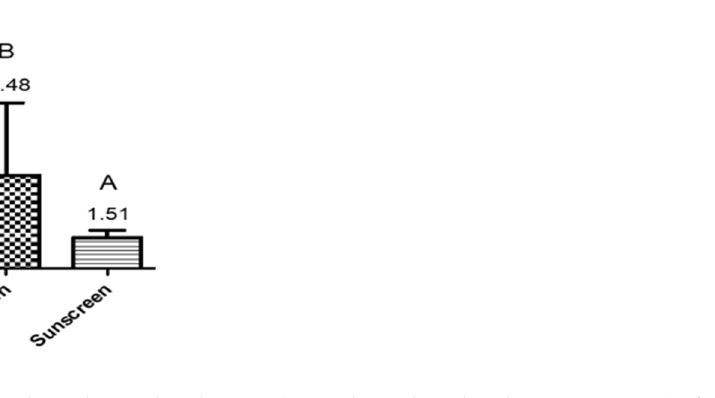
Figure 3. Ratio between values obtained at the sites (control, irradiated and sunscreen sites) of the HPLC-TBARS-EVSC assay. Different letters for the same parameter indicate statistically significant differences between samples (one-way ANOVA; p < 0.05; n = 10). Skin = stratum corneum .